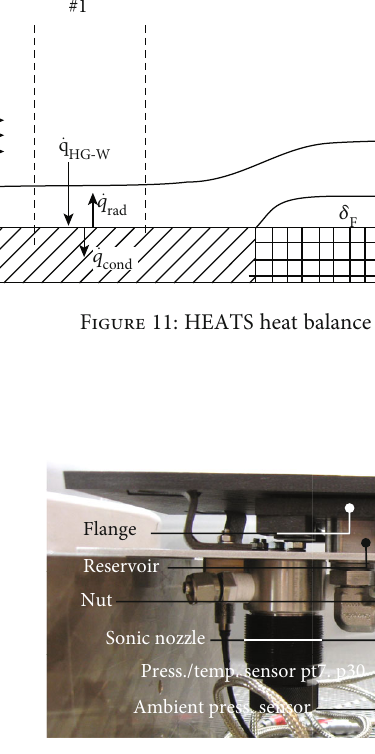
Figure 12: AKTiV side